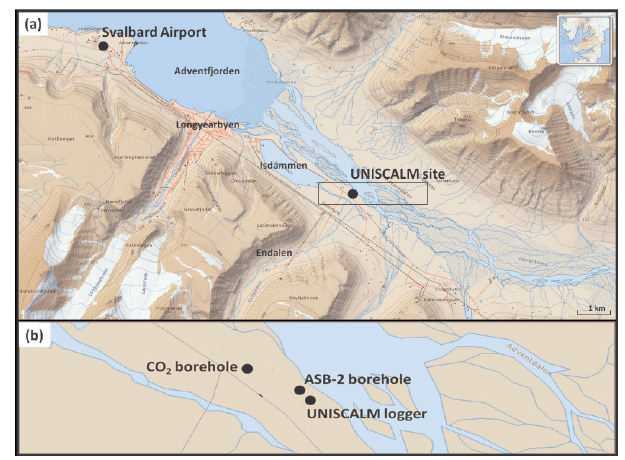
Figure 1. Lower Adventdalen in central Spitsbergen, Svalbard, showing the location of the UNISCALM site. The meteorological station is located at Svalbard Airport (data: Norwegian Polar Insti-